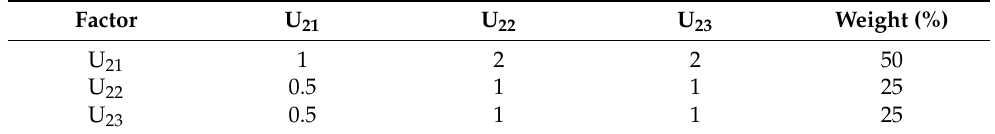
Table 6. Judgment matrix of SZSOJ’s second-level evaluation factors (U 2